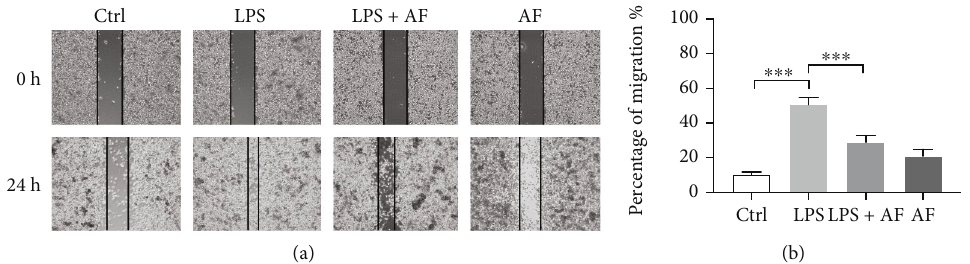
Figure 2: E ff ects of amento fl avone on LPS-induced migration of microglia in BV2 microglial cells. (a) Representative images of the wound- healing assays of BV2 microglial cells. (b) Analysis of migration indexes in di ff erent groups in BV2 microglial cells. Error bars represent mean ± s : d . ∗∗∗ represent P < 0 : 001 , respectively. All experiments were performed in triplicate. LPS: lipopolysaccharide; AF: amento fl